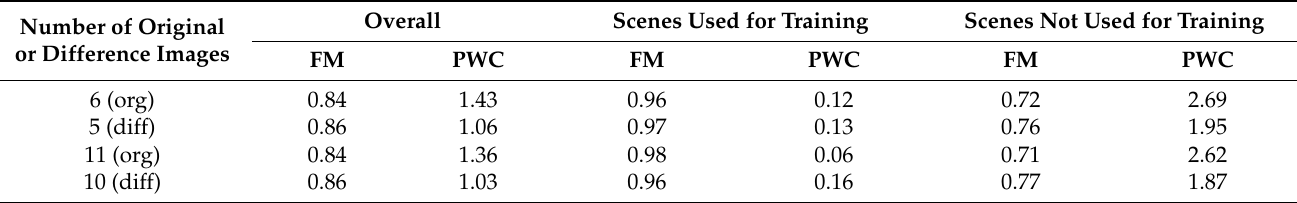
Table 5. Comparison results of using multiple original images and multiple difference images as the input of networks within a 50-frame